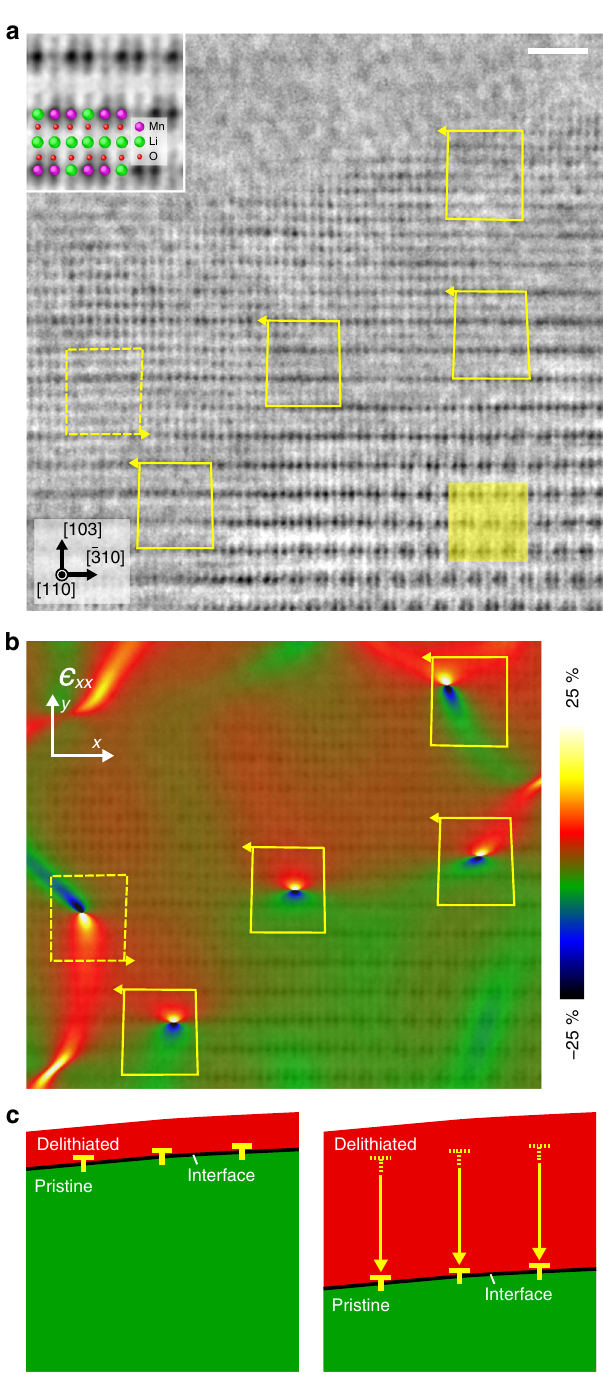
Fig. 3 Atomic-resolution ABF-STEM imaging and GPA analysis in delithiated Li 2 MnO 3 . a ABF-STEM image simultaneously recorded with Fig. 2b. The inset is an enlarged image of the yellow squared region as a bulk. b The ϵ xx strain map obtained from a . c A schematic view of delithiation process. The scale bar in a is 1